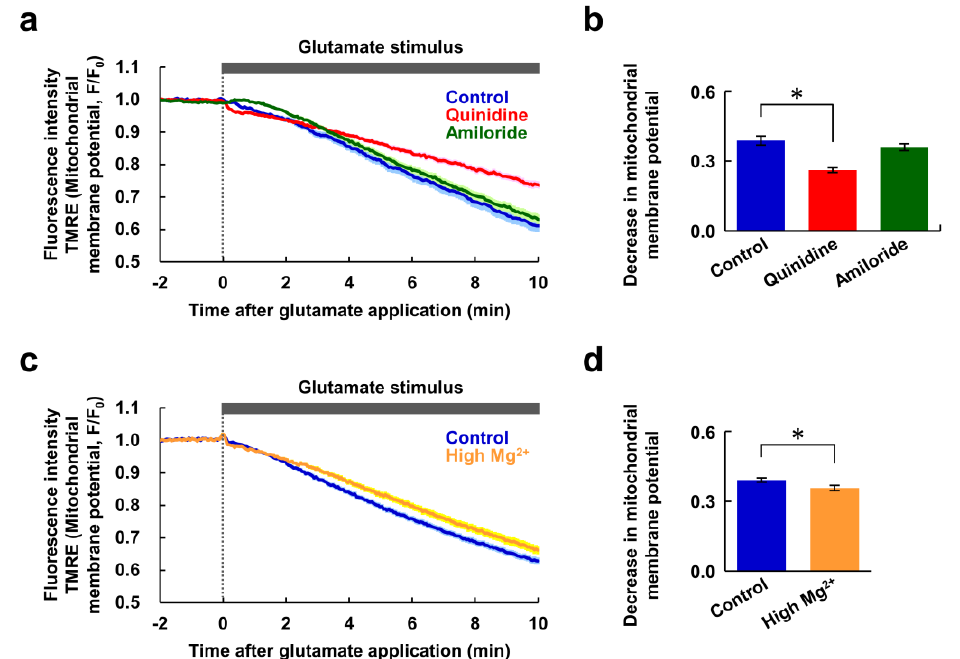
Figure 4. Changes in mitochondrial membrane potential in response to glutamate stimulus. ( a ) Time-courses of changes in mitochondrial membrane potential in response to the glutamate stimulus (blue: control, n = 90 cells; red: with quinidine at 200 µ M, n = 89 cells; green: with amiloride at 500 µ M, n = 100 cells, from 5 replicates each). Data are presented as the average (solid line) ± SEM (shaded area). ( b ) Comparison of decreases in mitochondrial membrane potential after 10 min extracted from the data shown in ( a ). Error bars indicate SEM. * indicates P < 0.05 compared with control by Dunnett’s test. ( c ) Time-courses of changes in mitochondrial membrane potential in response to the glutamate stimulus (blue: control, n = 75 cells; yellow: under high Mg 2+ (8 mM) condition, n = 80 cells, from 5 replicates each). Data are presented as the average (solid line) ± SEM (shaded area). ( d ) Comparison of decreases in mitochondrial membrane potential after 10 min extracted from the data shown in ( c ). Error bars indicate SEM. * indicates P < 0.05 by t-test.